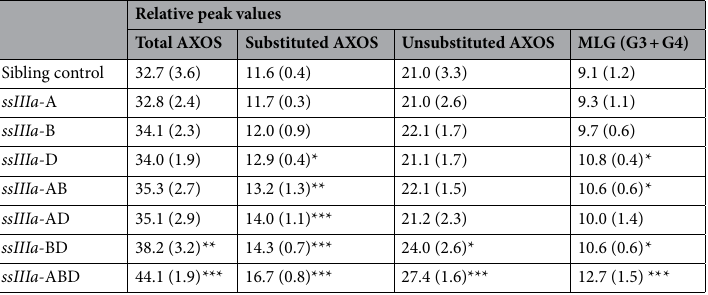
(Table S4). There were no significant differences in enthalpy and onset temperature between the triple mutants and sibling controls (Table S4). Soluble sugars. Soluble sugars (glucose, fructose and sucrose) were measured in grains of triple mutant and wild-type sibling controls harvested at 25 days after anthesis (DAA) and maturity. At 25 DAA, sucrose levels in the triple mutant were significantly greater, 3.04 mg/grain vs 1.00 mg/grain in the sibling control, ( P < 0.001) (Table S6). At maturity, the triple mutant had both higher levels of fructose (0.18 mg/grain vs 0.10 mg/grain in the sibling control, P = 0.042) and sucrose (1.09 mg/grain vs 0.57 mg/grain in the sibling control, P = 0.0037) (Table S6). Overall, the total level of soluble sugars (sum of glucose, fructose and sucrose) at 25 DAA and matu- rity were higher in the triple mutant compared to the wild-type sibling controls ( P = 0.0001 and P = 0.0005 respectively) (Table S6).